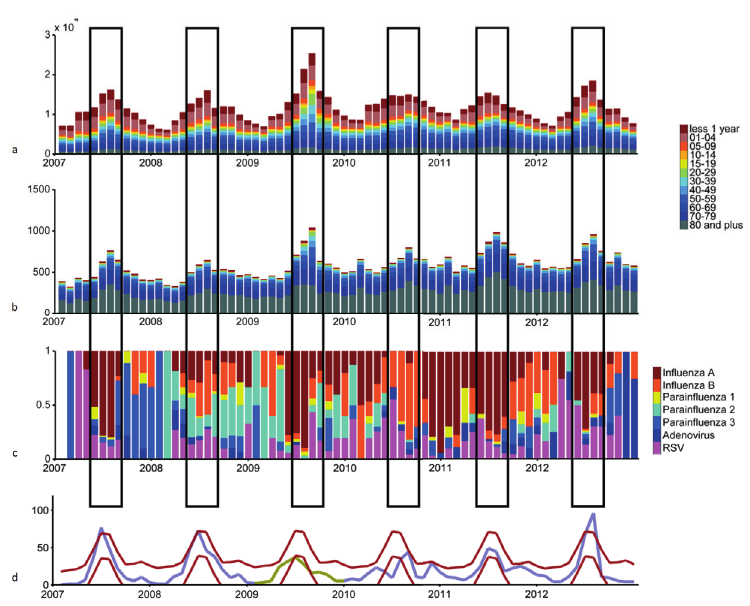
Figure 6. Epidemic monthly series of the “Sub-tropical South” zone: ( a ) Hospitalizations in the public sector, ( b ) deaths, ( c ) proportion of respiratory viruses detected ( d ) total respiratory viruses detected and periodic annual function (PAF, when 2009 is